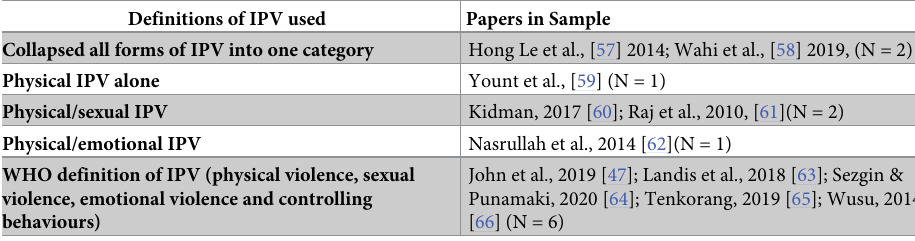
Table 3. Intimate partner violence reported in included